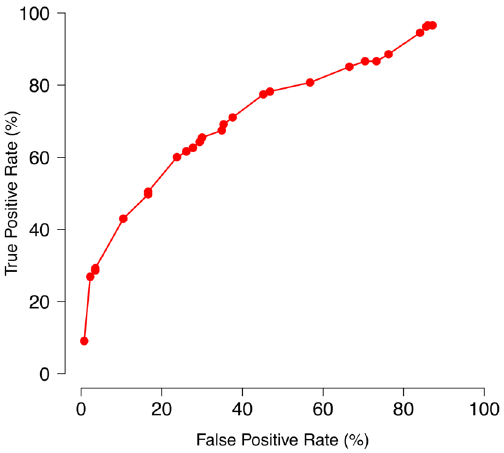
Figure 12. Model performance for case-control classification of autism using rare CNVs, with greater number of splits. Legend identical to Figure 9, except that here the graph is comprised of 30 measures because features are scored out of 30, rather than in Figure 9 , where features are scored out of